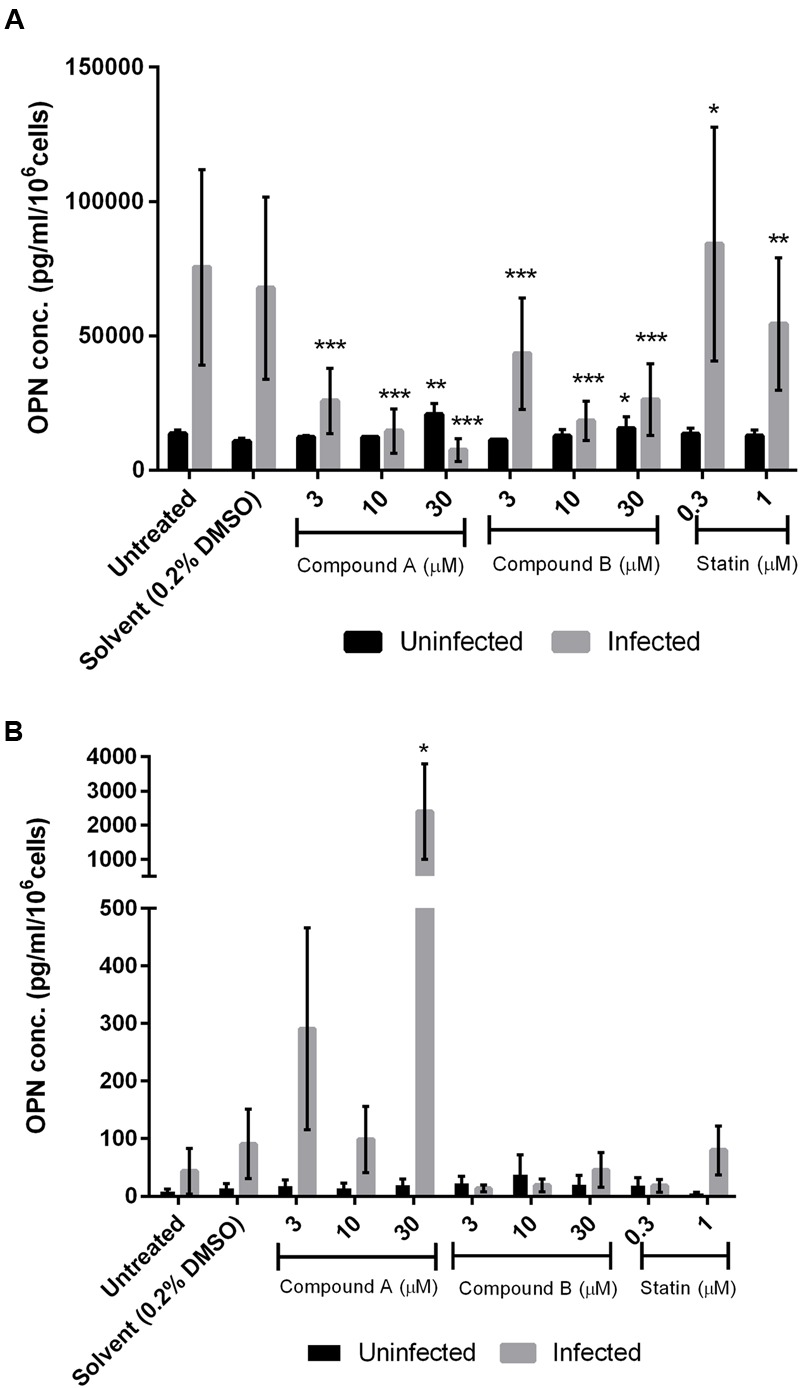
Effect of compounds A and B on OPN protein level in DENV-infected cells. Uninfected and DENV-infected THP-1 (A) or 293T (B) cells were left untreated or treated with compound A or compound B (range: 3–30 μM), or statin (range: 0.3–1 μM) for 72 h. Cells were then harvested and OPN levels in the culture supernatant were determined by ELISA. Viability was simultaneously measured to normalize the results. Normalized OPN levels in each sample are expressed as pg/ml/106 cells. Results show the mean of two independent experiments. ∗P < 0.05, ∗∗P < 0.01, ∗∗∗P < 0.001 vs. control (0.2% DMSO; unpaired two-tailed t-test). Data represent mean ± SEM.